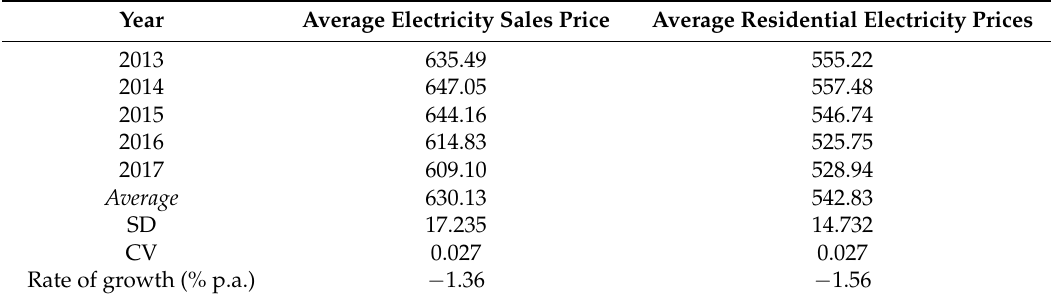
Table 2. Average electricity sales price and average residential electricity prices in China (national averages), 2013–2017 (in CNY/MWh).